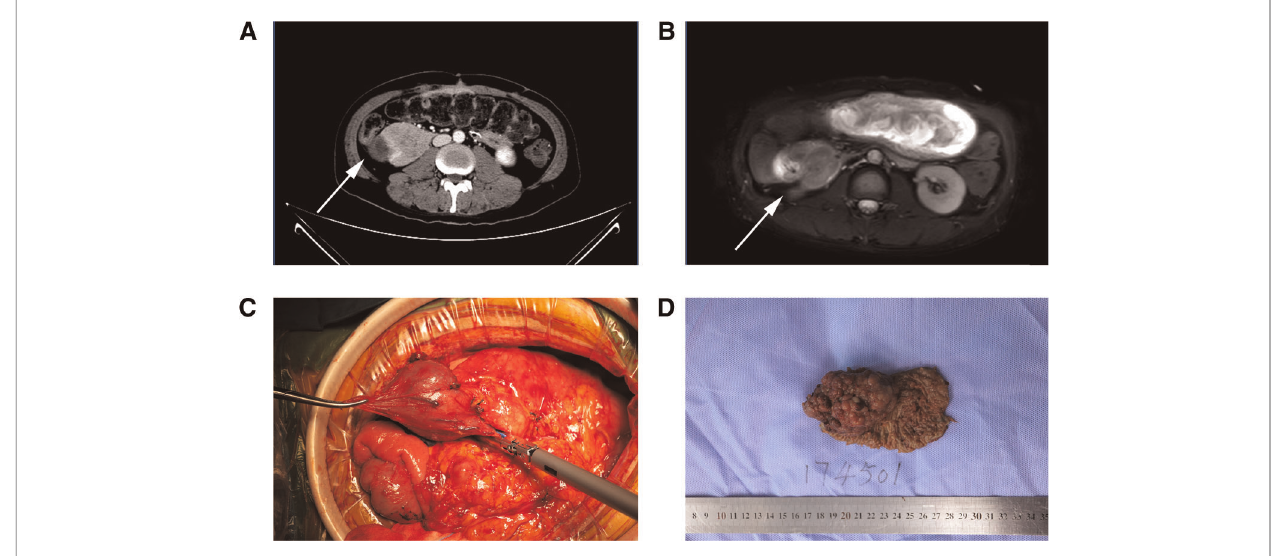
FIGURE 2 | ( A , B ) CTV (left) and MRI (T2WI) (right) revealed a space-occupying lesion located in the descending part of the duodenum, ( C ) huge tumor of the descending part of the duodenum was seen during the operation, ( D ) gross specimen of the dissected